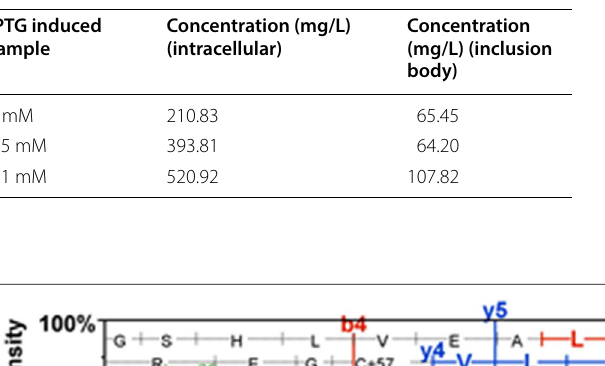
Table 1 The concentrations of human insulin obtained for the IPTG induction calculated based on commercial human insulin